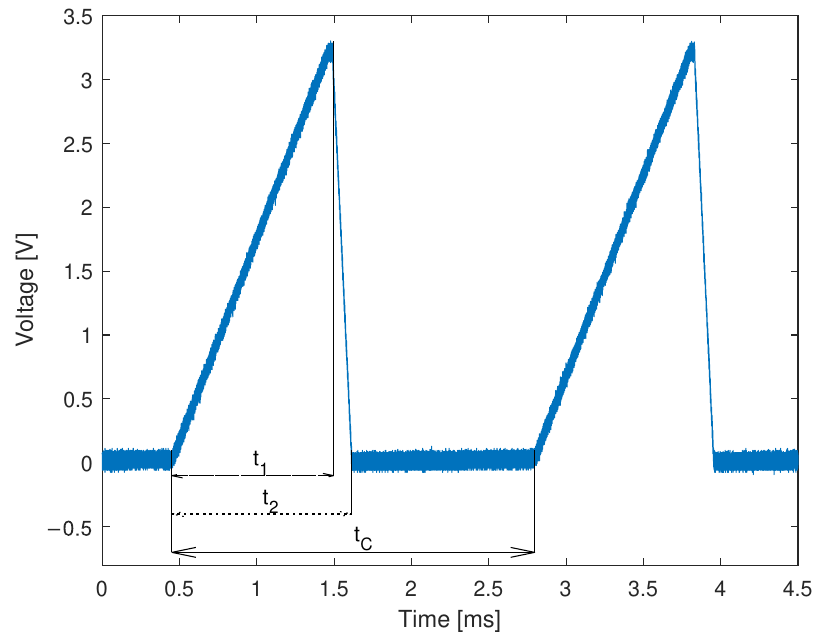
Figure 6. Voltage signal at the output of an STM32 DAC measured with LeCroy 202MXi oscilloscope. The ramp signal can be distinguished by three time-based parameters. The first t 1 is the rise time, the t 2 is the duration of a ramp, and the t C is the period of tuning